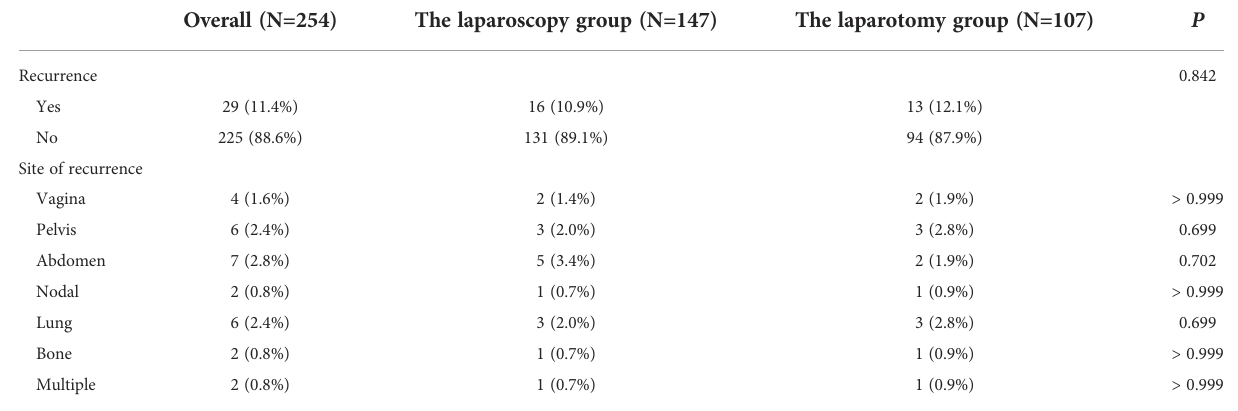
TABLE 2 Rates and patterns of disease recurrence a .